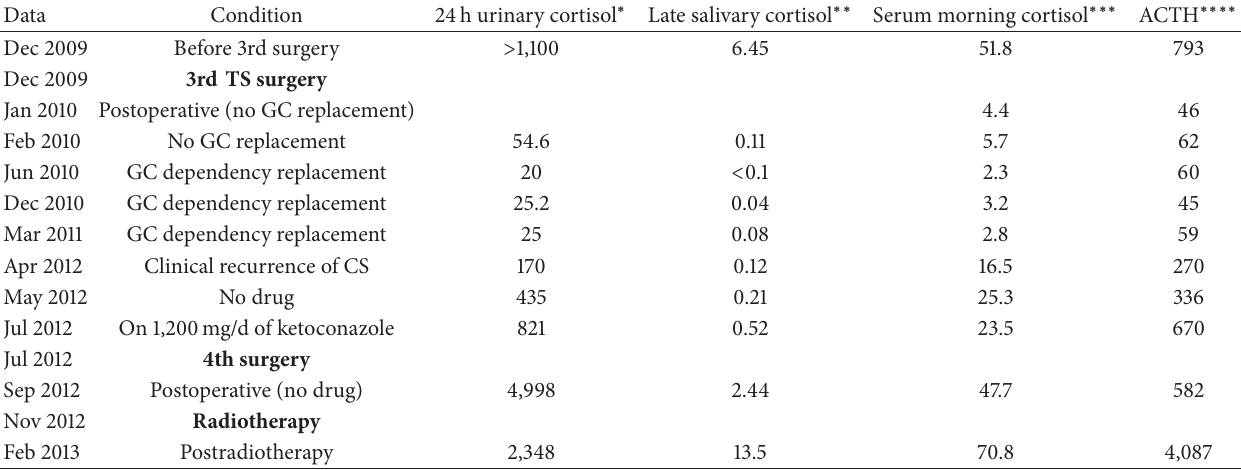
Table 1: Clinical course.